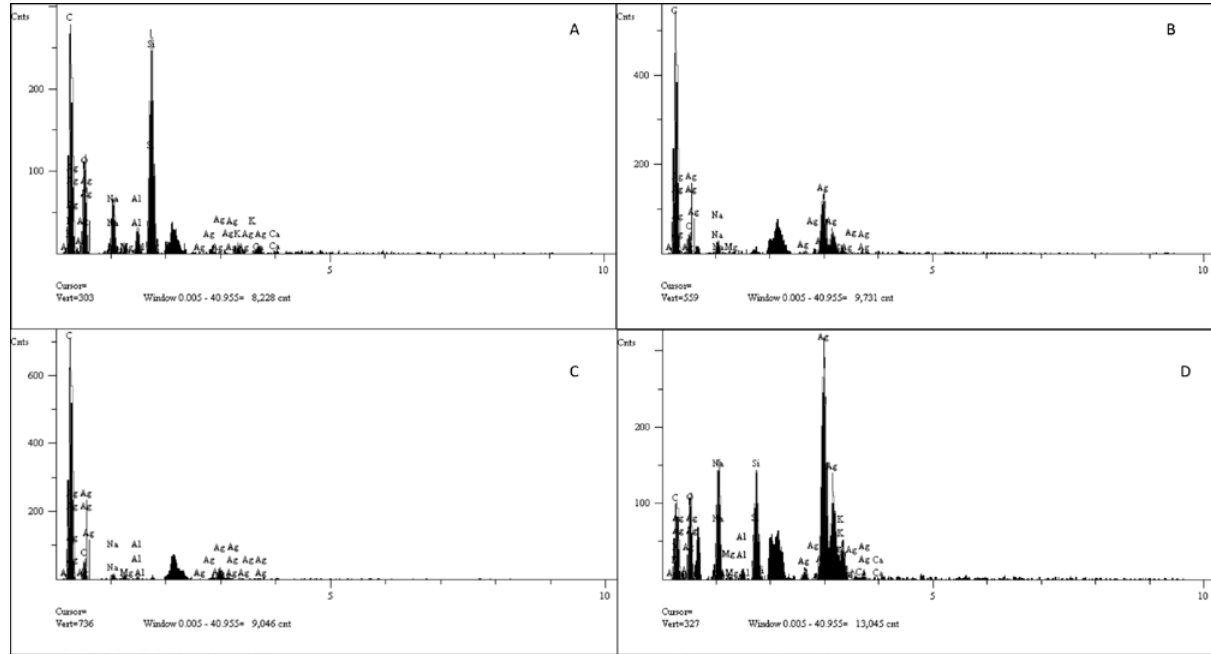
Fig. 4. SEM-EDS spectrum recorded from biosynthesized AgNPs A. Control group; B. LAC-AgNPs; C. RAE-AgNPs; D.